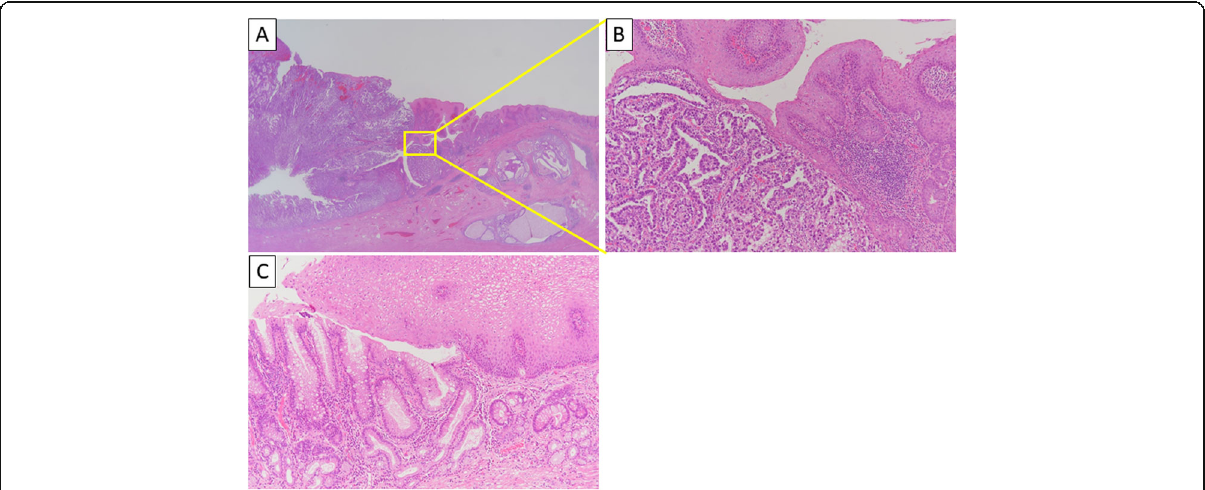
Fig. 1 Hematoxylin-eosin staining of the resected specimen. a Adenocarcinoma is present at the esophagogastric junction (× 20 magnification). b A moderately differentiated adenocarcinoma is present at the esophagogastric junction (× 200 magnification). c Distal esophageal squamous